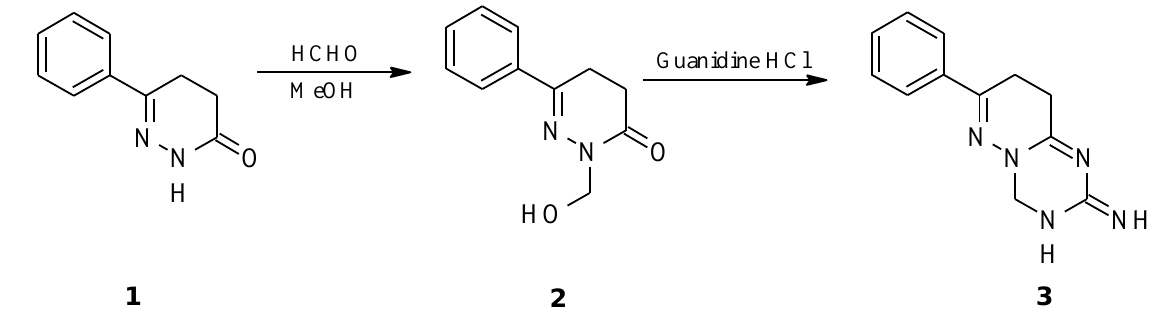
Figure 1. Synthetic route to the title compound 3